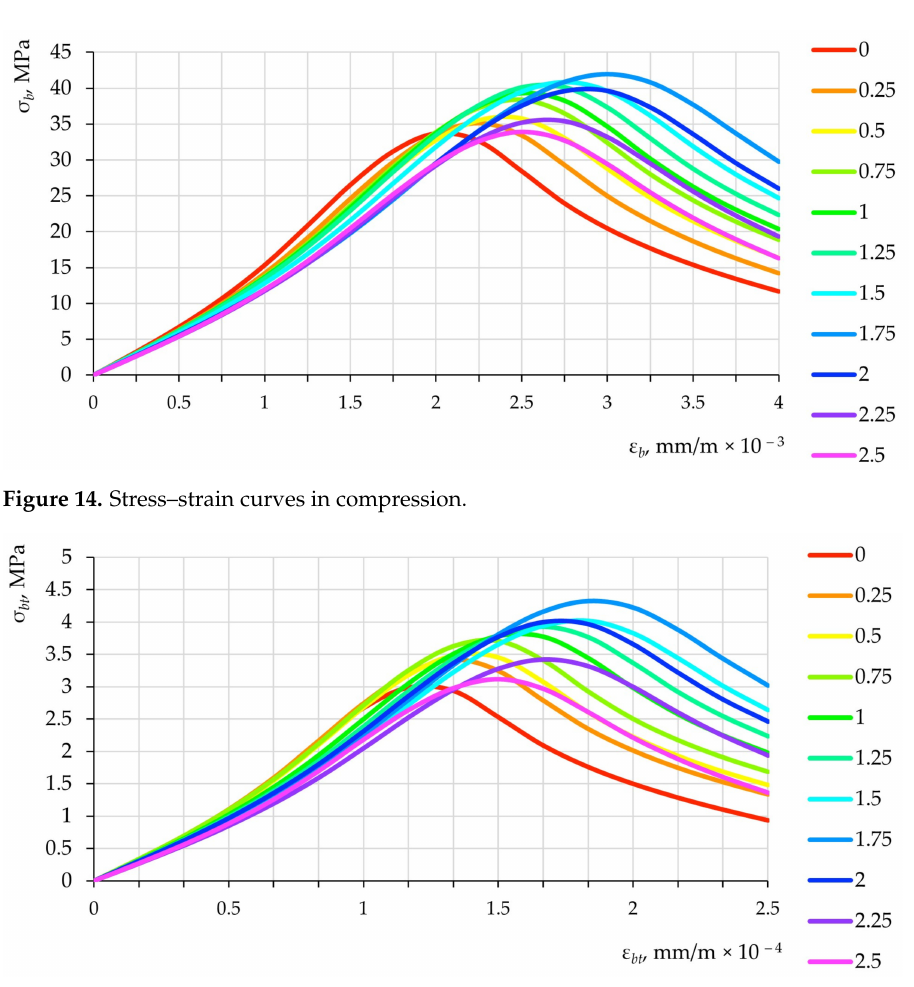
Figure 15. Stress–strain curves in